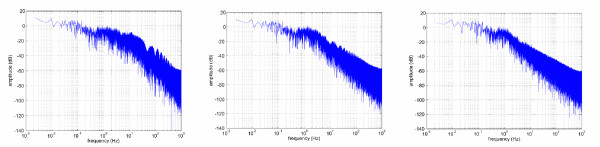
(left to right) Effects of the RMS on the bandwidth of the EMG signals, for TRMS = 20, 100, 500 ms.